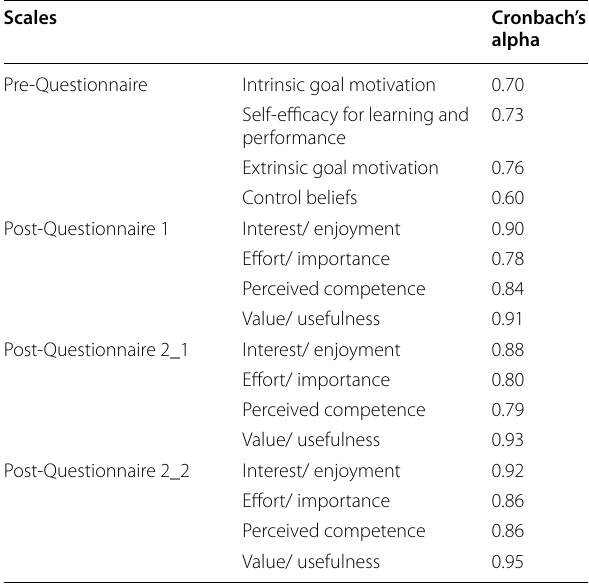
Table 1 Reliability statistics of Questionnaires’ scales (Cronbach’s